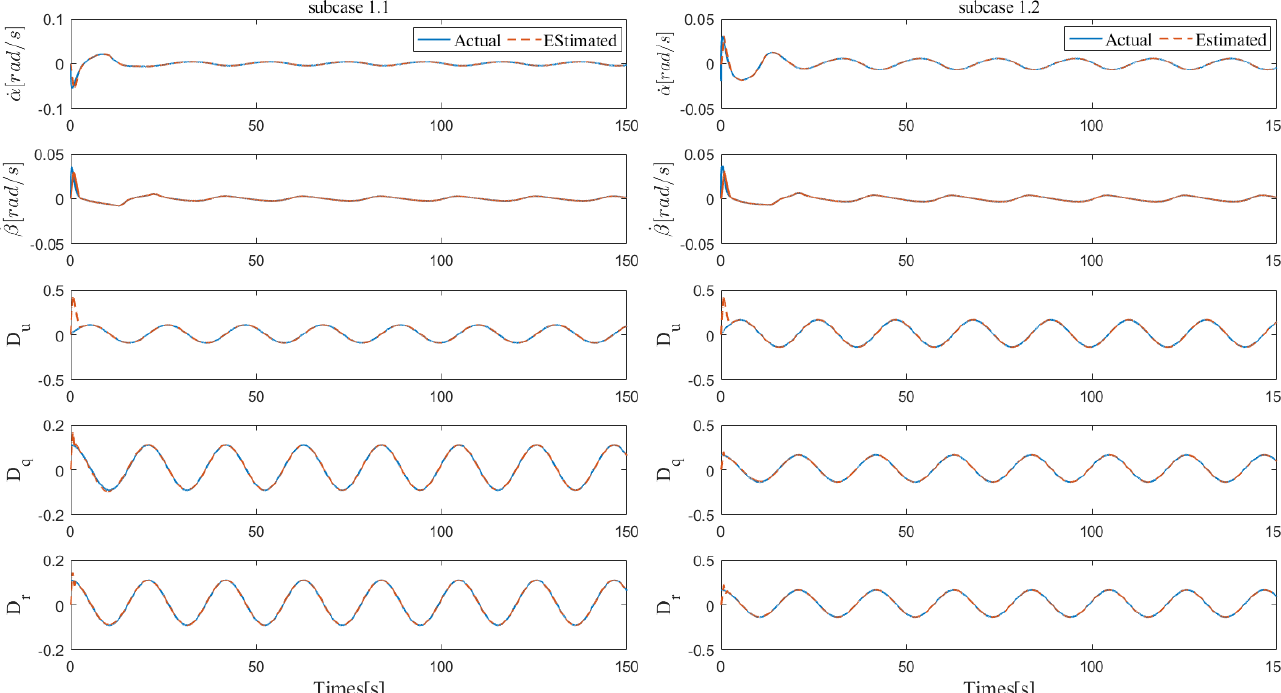
Figure 4. Tracking errors of Case 1.